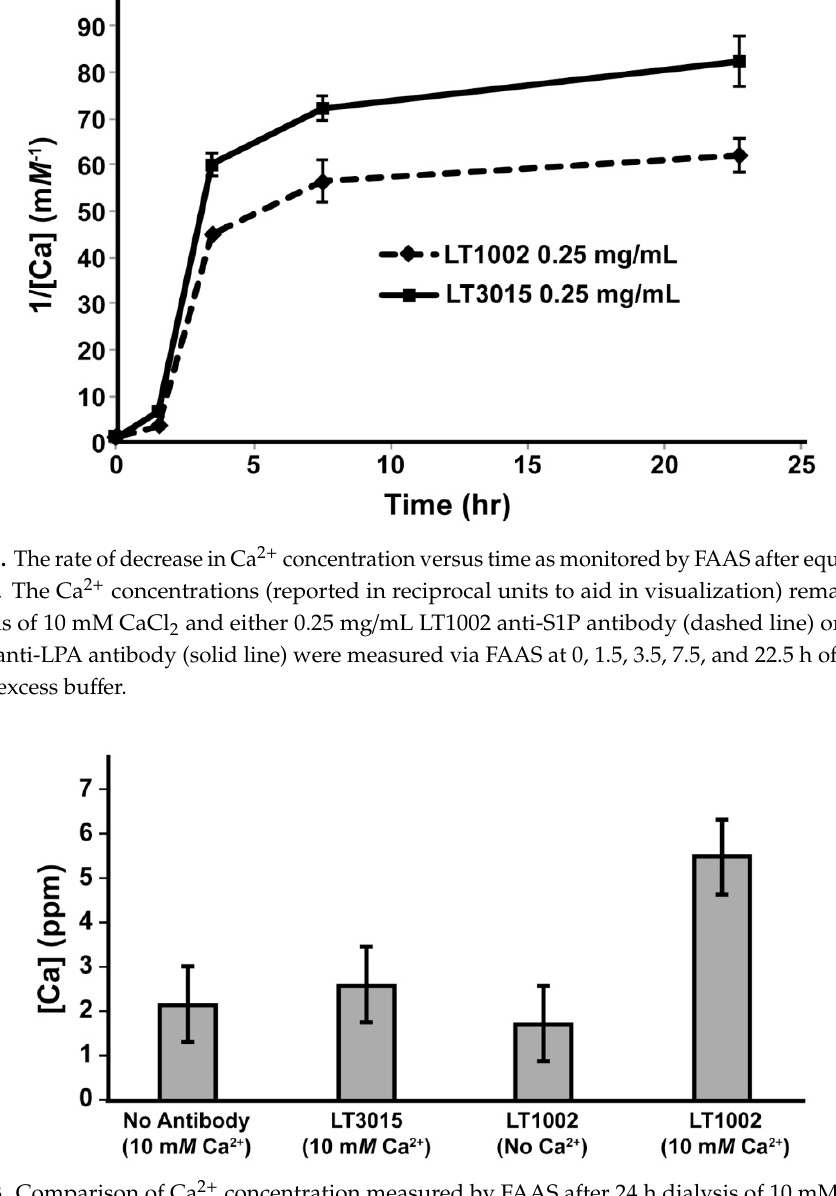
Figure 3. Comparison of Ca 2+ concentration measured by FAAS after 24 h dialysis of 10 mM Ca 2+ in the absence of antibody, in the presence of 0.9 mg/mL LT3015 anti-LPA antibody, and in the presence of 0.9 mg/mL LT1002 anti-S1P antibody.